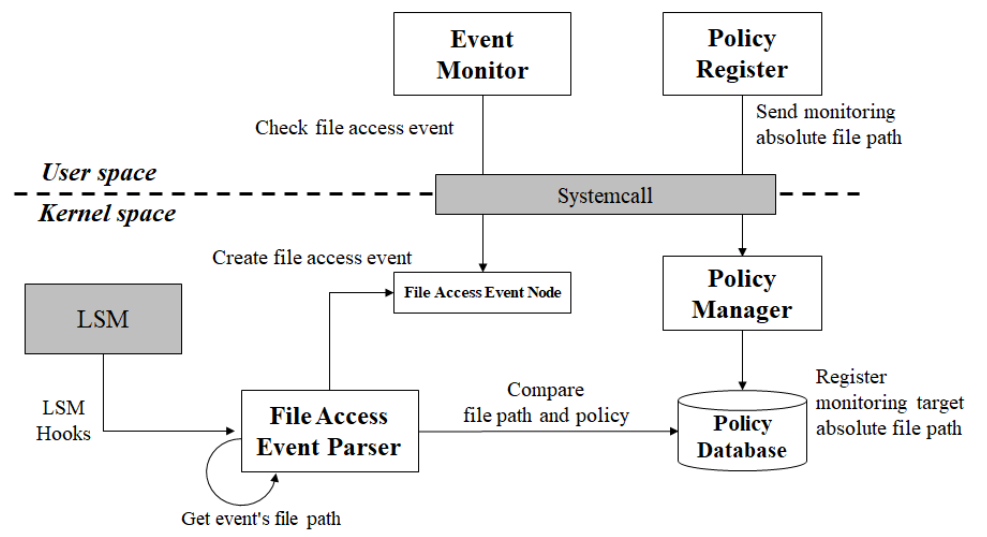
Figure 4. Real-time file access monitoring structure. Table 2. Difference between the proposed structure and legacy file access control security techniques